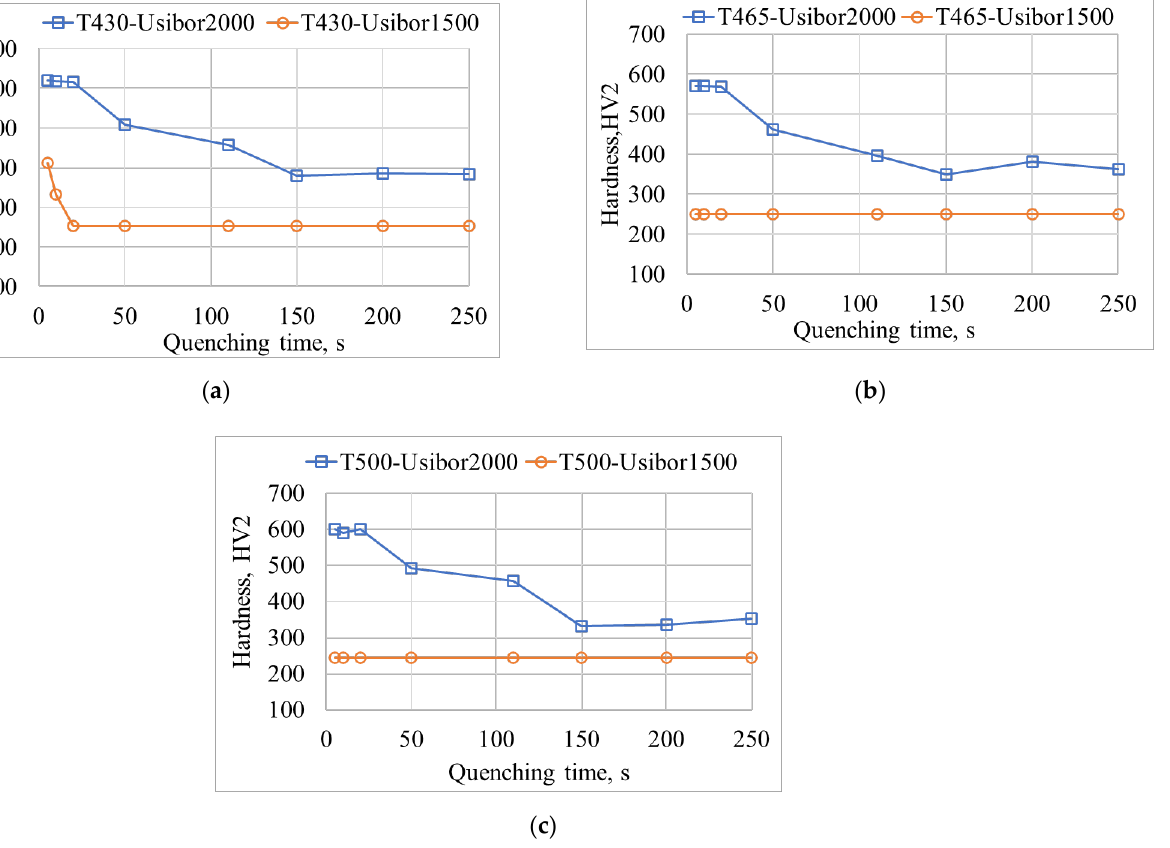
Figure 13. ( a ) . Hardness values for different quenching time at temperature of 430 °C; ( b ) Hardness values for different quenching time at temperature of 465 °C; ( c ) Hardness values for different quenching time at temperature of 500 °C.